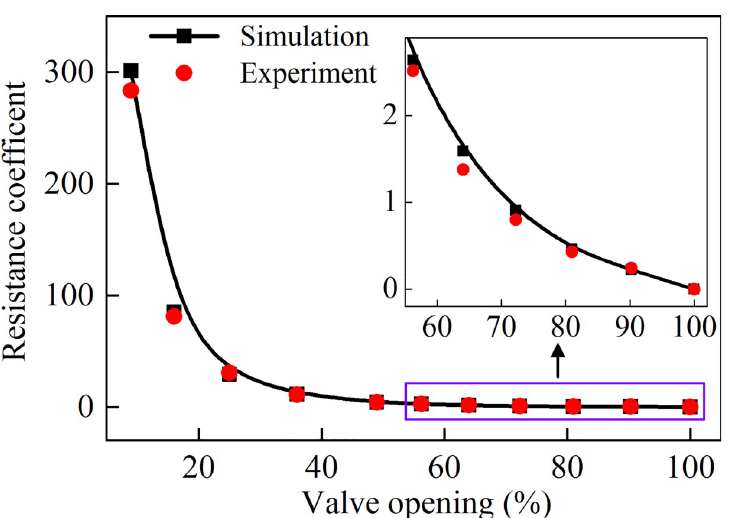
Fig 6. Comparison between the measured and simulated resistance coefficient of the air-ring flow regulating valve.